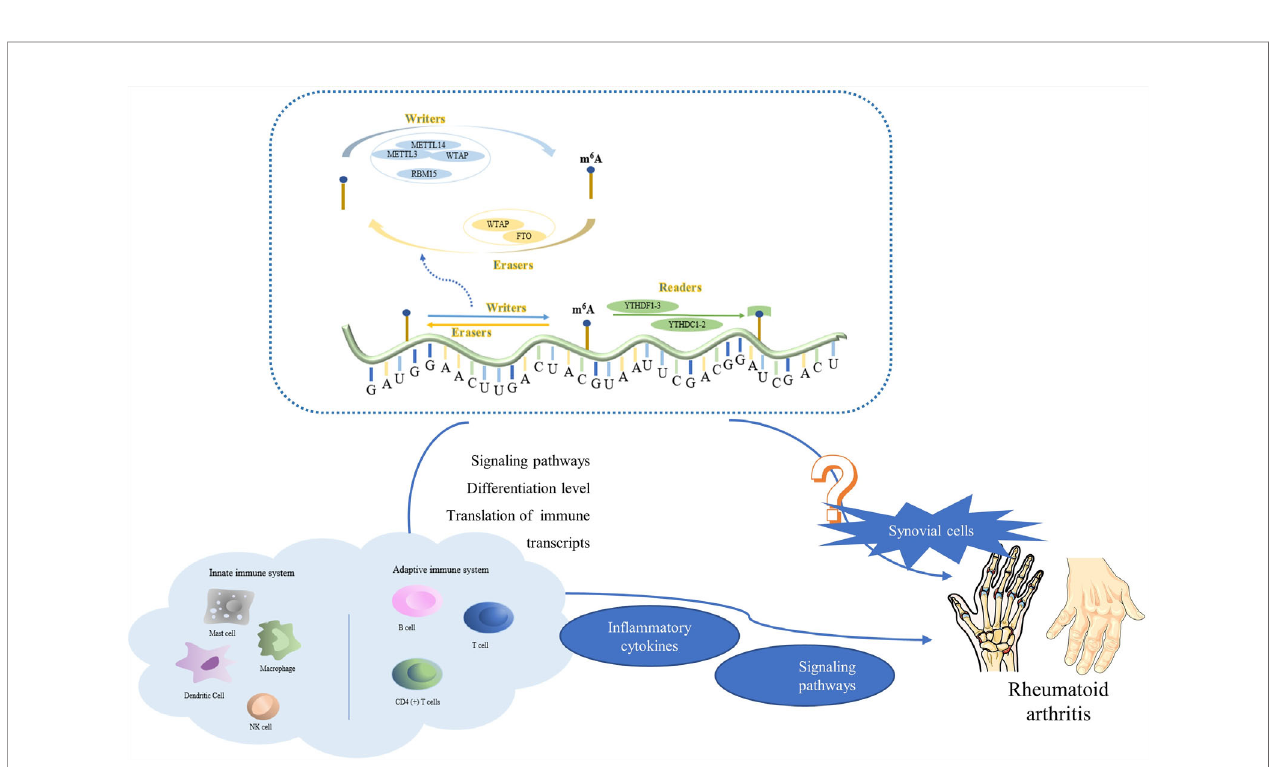
FIGURE 4 | The complexes formed by METTL3, METTL14, WTAP, and RBM15 are common writers; those formed by ALKBH5 and FTO are common erasers; and those formed by YTHDC1, YTHDF1, and YTHDF3 are common readers. M 6 A methylation is involved in a wide range of biological regulatory processes in the innate and adaptive immune systems, such as adjustment of signaling pathways, differentiation, translation of immune transcripts. It controls the production of in fl ammatory factors, in fl ammation-related signaling pathways, and other genes that have a direct impact on RA. It is worth noting that, m 6 A methylation may also directly affect synovial cell proliferation and tumor tissue, which may be a potential discovery in future RA